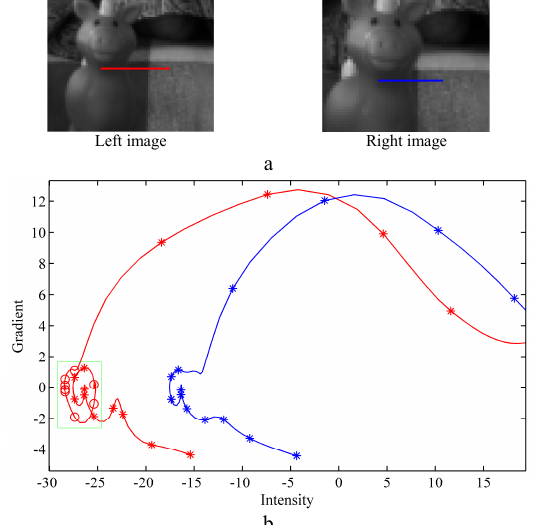
b Figure 3. (a) One part of left and right corresponding scanlines with partial occlusions; (b) Intrinsic curves demonstrating matched pixels (shown by stars) and occluded pixels (shown by circles in the green frame). As it can be noticed, occlusions happen at left arcs whose curvature changes are not similar to the right arcs. In other words, the curvature of the left curve changes the same way as the curvature of the right curve between any two non-occluded corresponding points; i.e. the curve remains either concave or convex in both curves. To formulate this